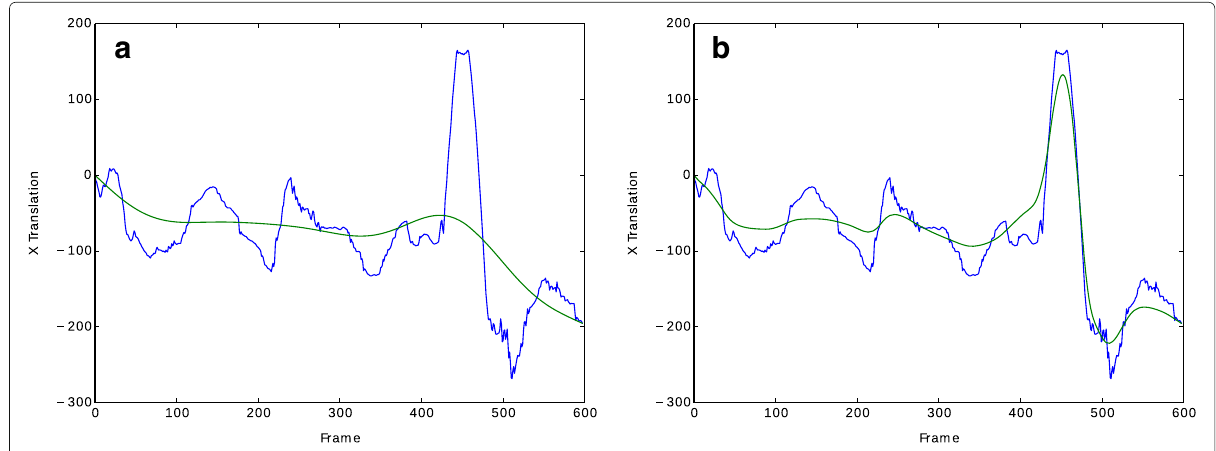
Fig. 4 Smoothing of camera motion trajectories. a Gaussian filter with σ = 40. b Adaptive Gaussian